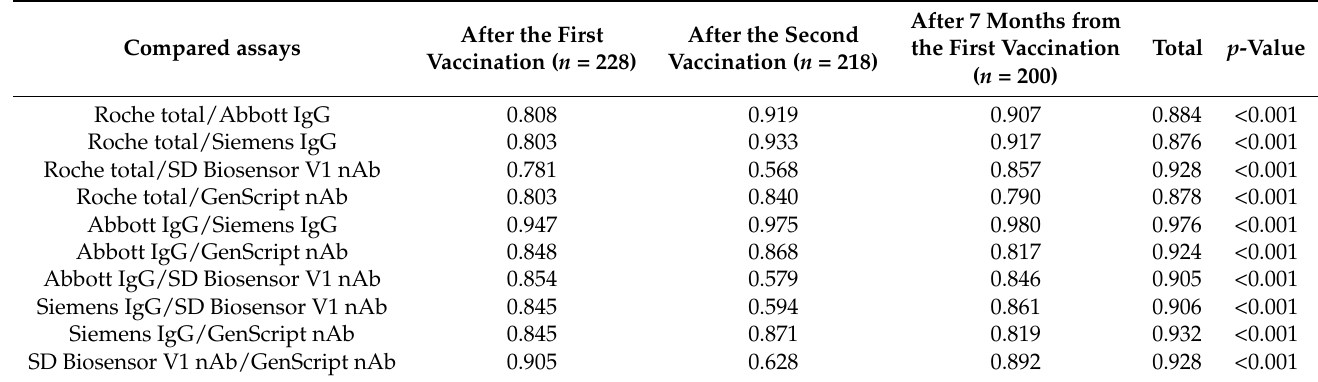
Table 4. Correlations among the five SARS-CoV-2 antibody assays according to the sampling time after vaccination.